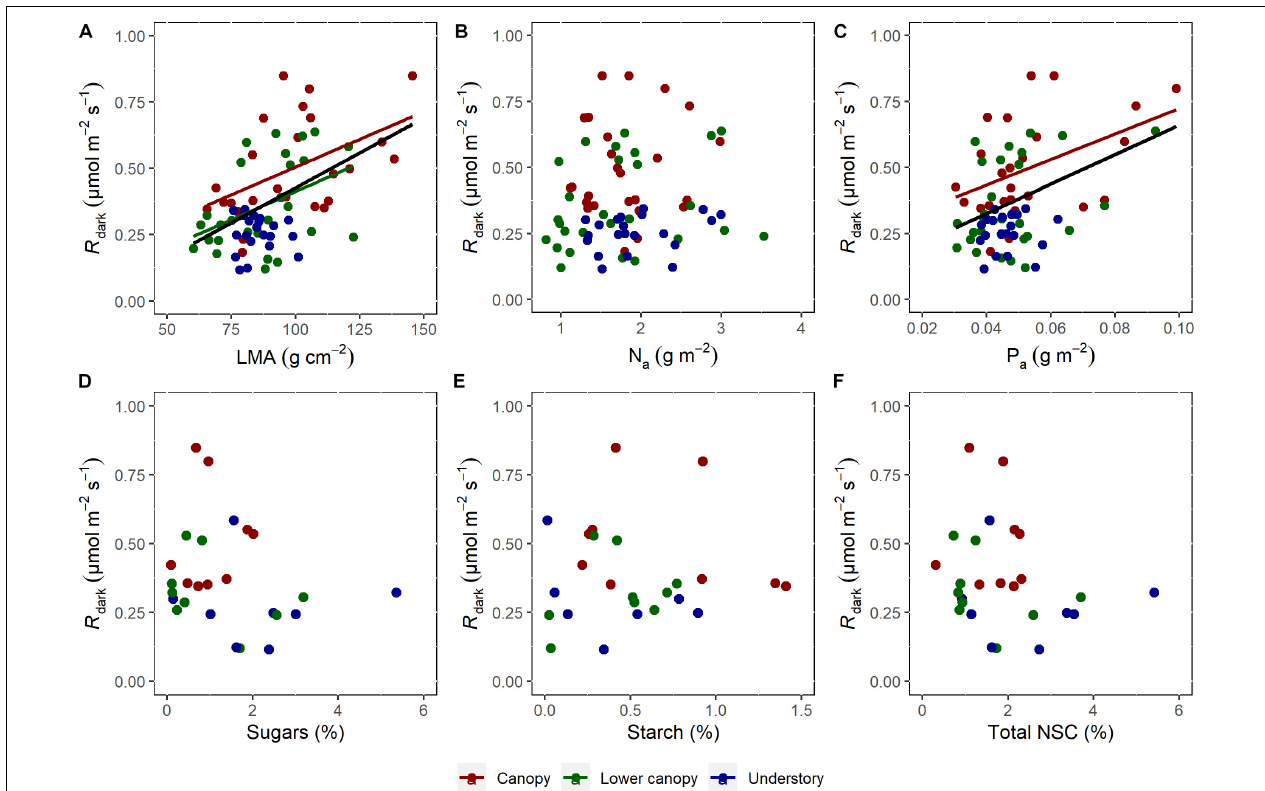
FIGURE 5 | Respiration rates in the dark as a function of LMA (A) , nitrogen (B) , phosphorus (C) , ( n = 76). Sugars (D) , Starch (E) , and Total NSC (F) , ( n = 26). The data was derived from the measurements collected in understory (blue), lower canopy (green), and canopy (red) trees. Results from the standardized major axis (SMA) regression are presented in Supplementary Table 2 . Note that when no significant relationship between the variables was found, the regression line was